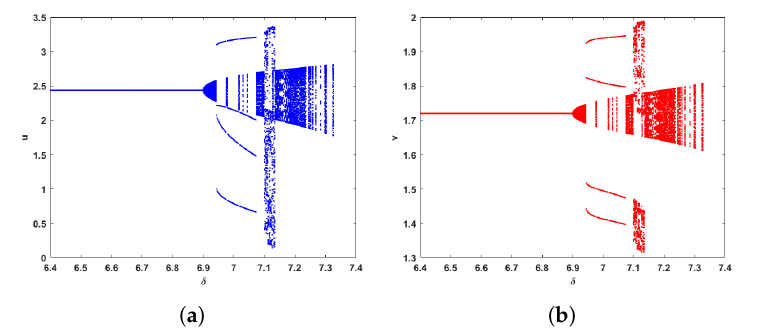
Figure 5. ( a , b ) Bifurcation diagram corresponding to u and v in system (2) with δ ∈ [6.4, 7.4], r 1 = 0.8, r 2 = 0.8, a = 0.4, b = 0.2, c = 2, d = 0.1, k = 5, h 1 = 0.1, h 2 = 0.1, the initial value is ( u , v ) = (3,